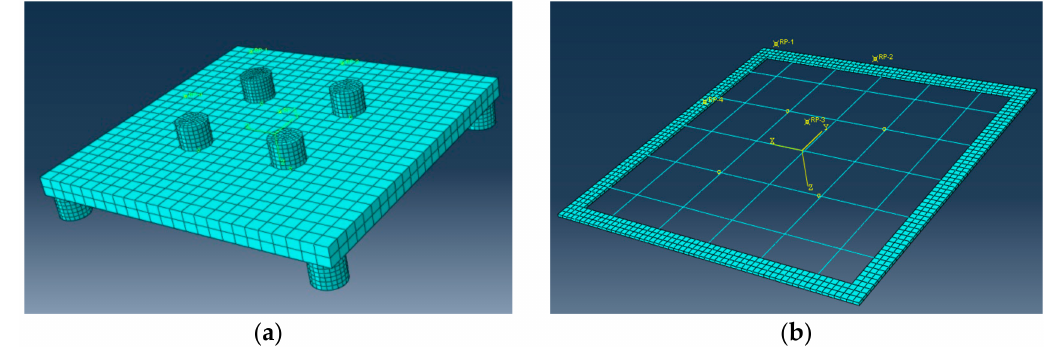
Figure 18. Mesh partition of modeled specimen. ( a ) Concrete meshing; ( b ) Steel skeleton meshing.